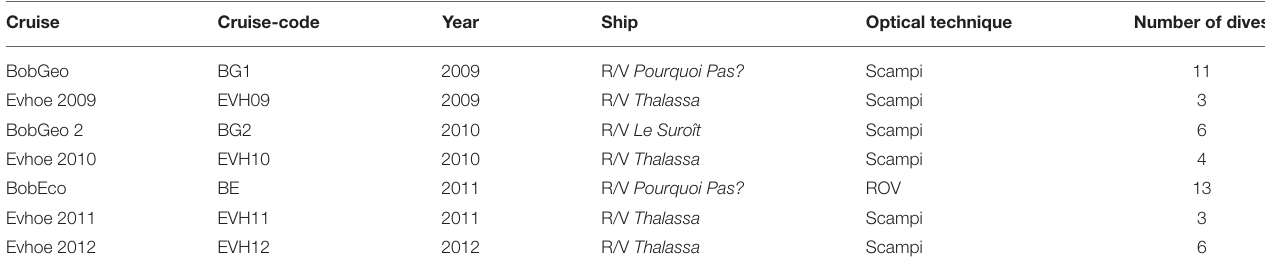
TABLE 1 | Dive information including cruise name, year, ship, the optical technique that is used and the number of dives analyzed during this study.